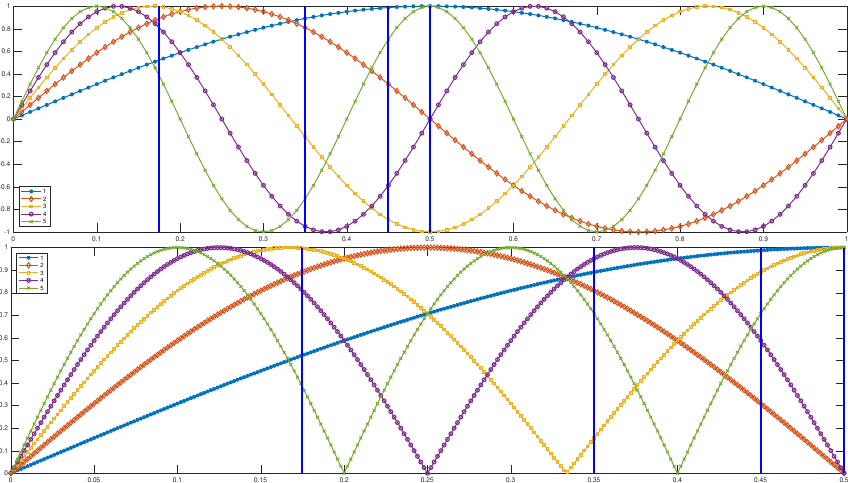
Figure 7. The shapes of the modes and the locations of the damage. The bottom plot considers the symmetry, and it is given in absolute values.